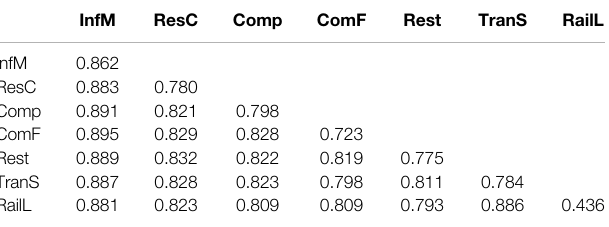
TABLE 5 | Interaction among these factors on the COVID-19 epidemic